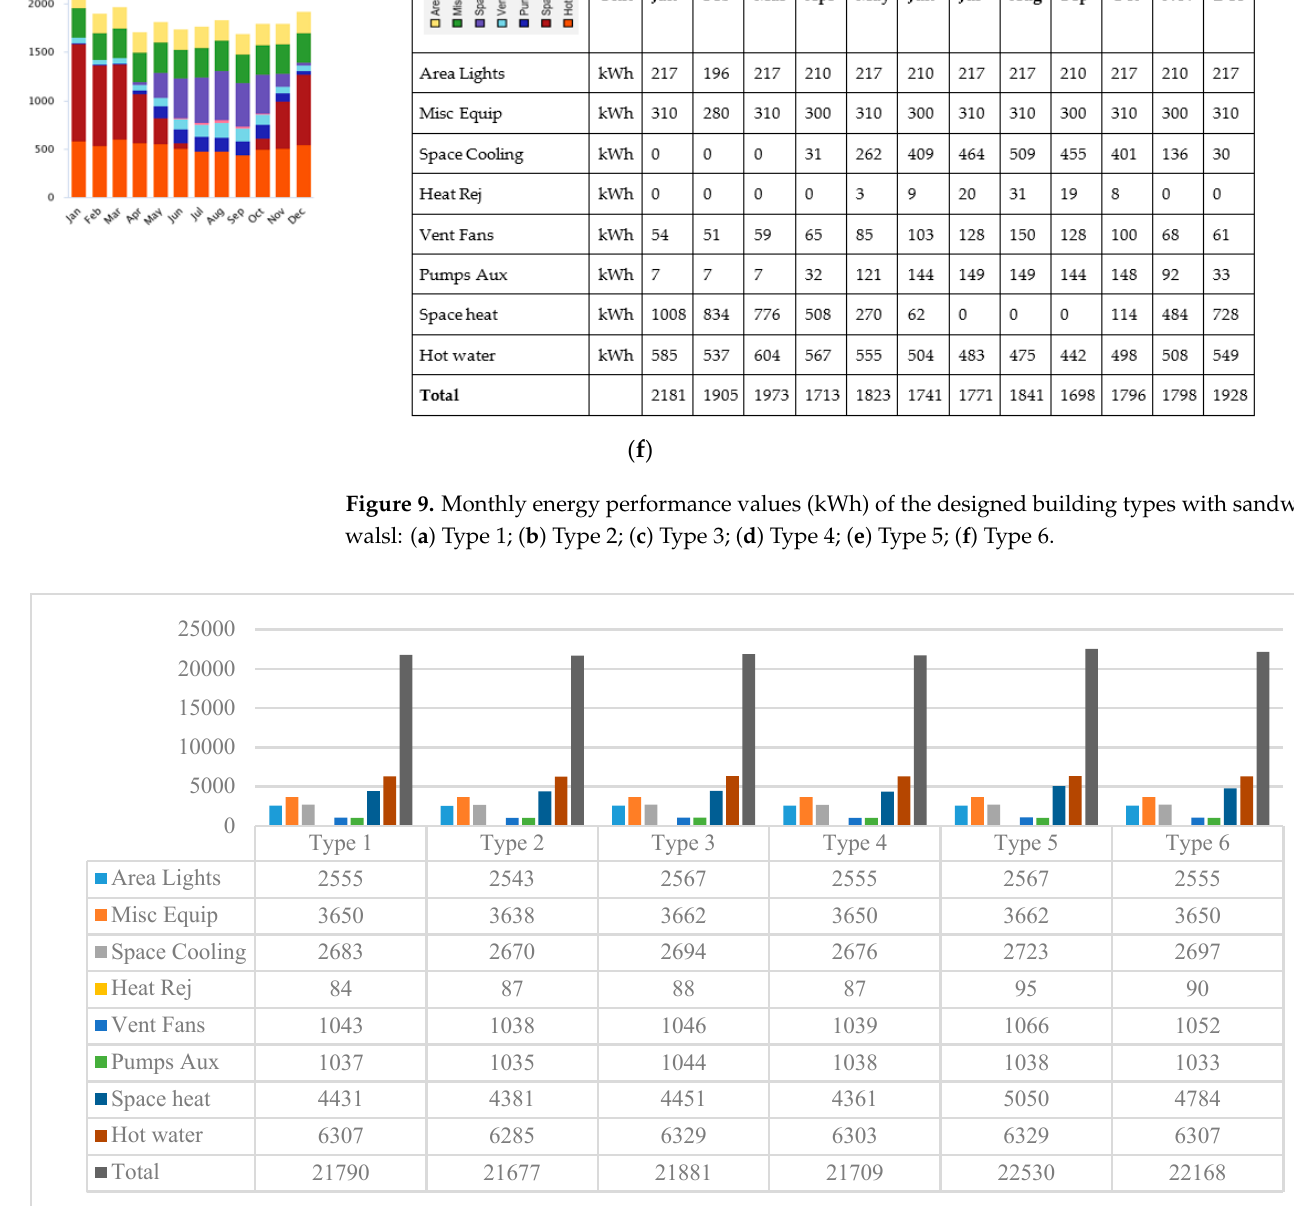
Figure 10. Total energy consumption of designed building types.